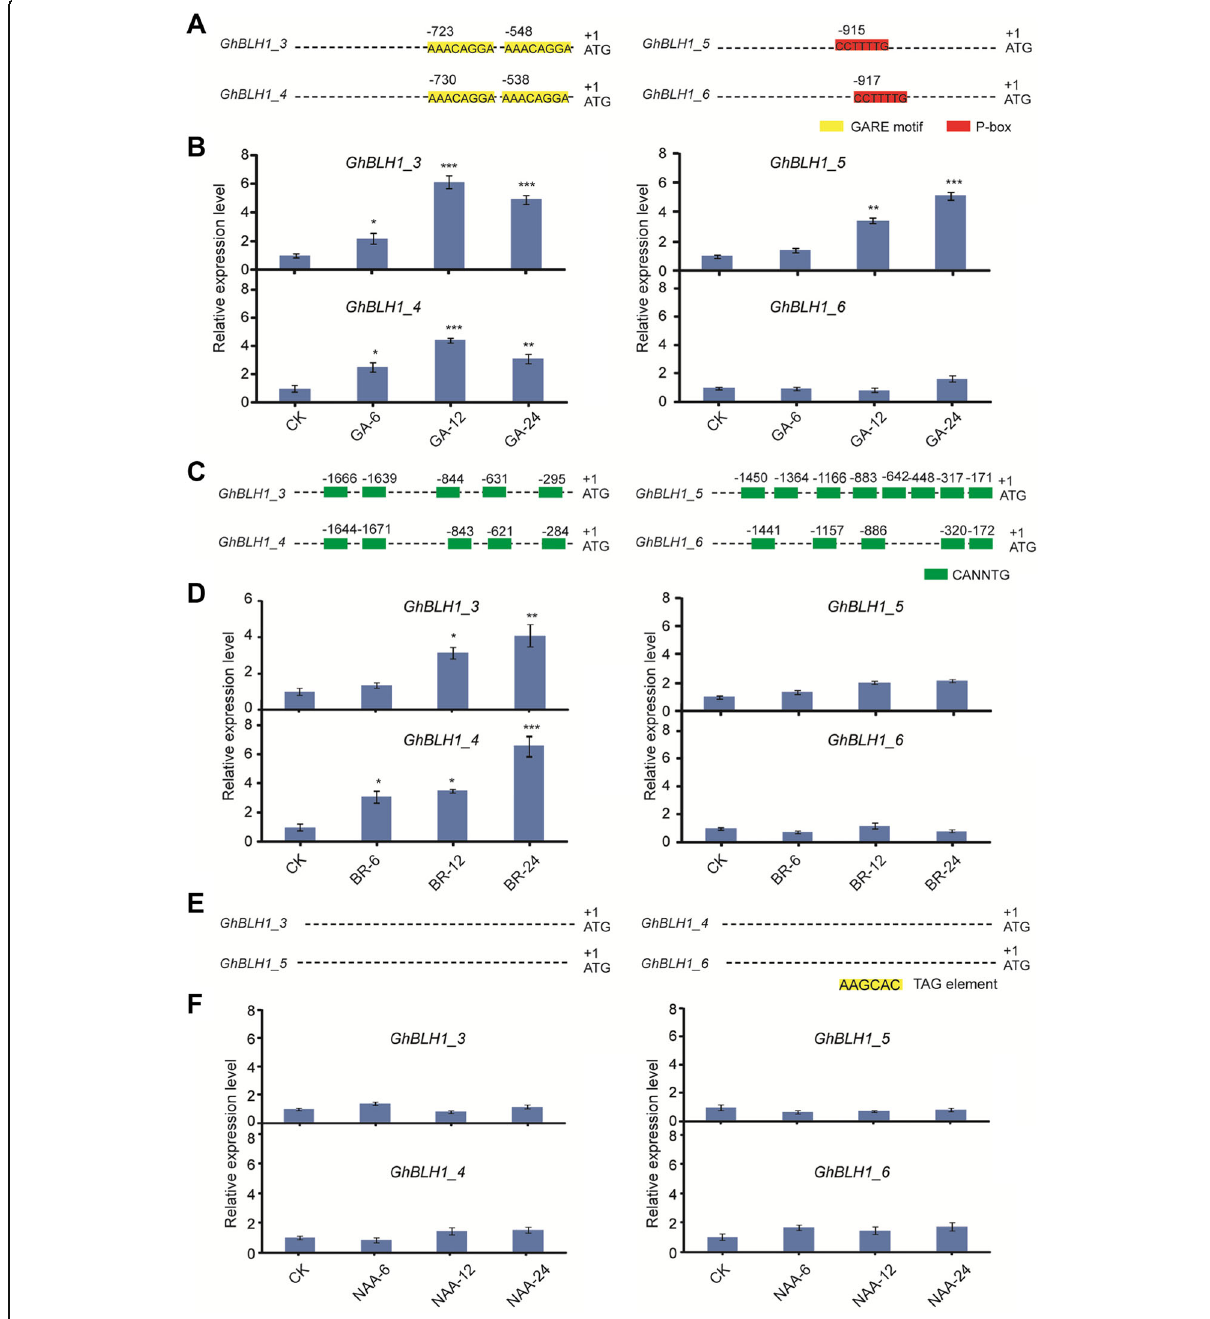
Fig. 5 Expression patterns of several GhBLH genes within ovules under GA, BR, and NAA treatment, respectively. a Analysis of GhBLHs with GAREs and P-boxes presented in their promoter regions. b GA activated significant transcription of three GhBLH genes with GAREs and P-boxes in their promoter regions. c Analysis of GhBLHs with CANNT presented in their promoter regions. d BR promoted significant transcription activation of two GhBLH genes with CANNTG. e Analysis of GhBLHs with TAG elements presented in their promoter regions. f NAA failed to activate the transcription of four GhBLH genes with TAG elements. Relative expression levels were determined after normalizing all data to that of CK ovules, which was set to 1.0. Statistical significance was determined using one-way analysis of variance combined with Tukey ’ s test. * P < 0.05; ** P < 0.01; *** P < 0.001. Note: The x-axis represents different hours (6, 12, and 24) after GA, BR, and IAA treatment, the y-axis indicates the relative expression levels. Error bars show the standard deviation of three biological